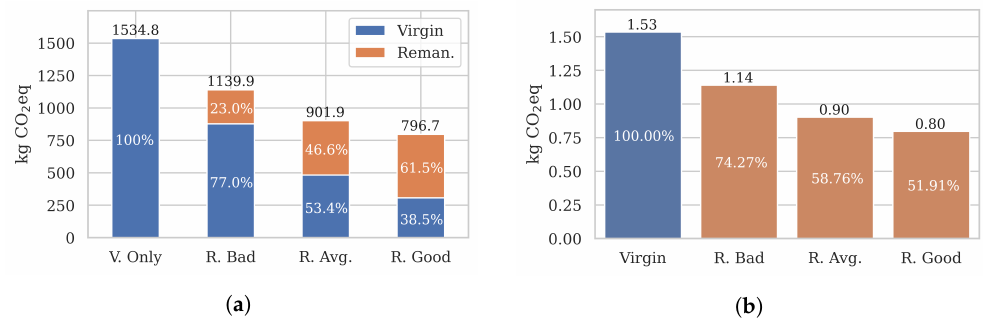
Figure 9. Emission results of a realistic buyback scheme. A total of 1000 catheter uses U were considered. The proportion of virgin and remanufactured catheter uses are given in Table 8. The results show that remanufacturing may reduce long-term emissions by up to 48%. ( a ) Burdened long-term emissions E l . ( b ) Burdened long-term emissions E l . perTurn perScheme